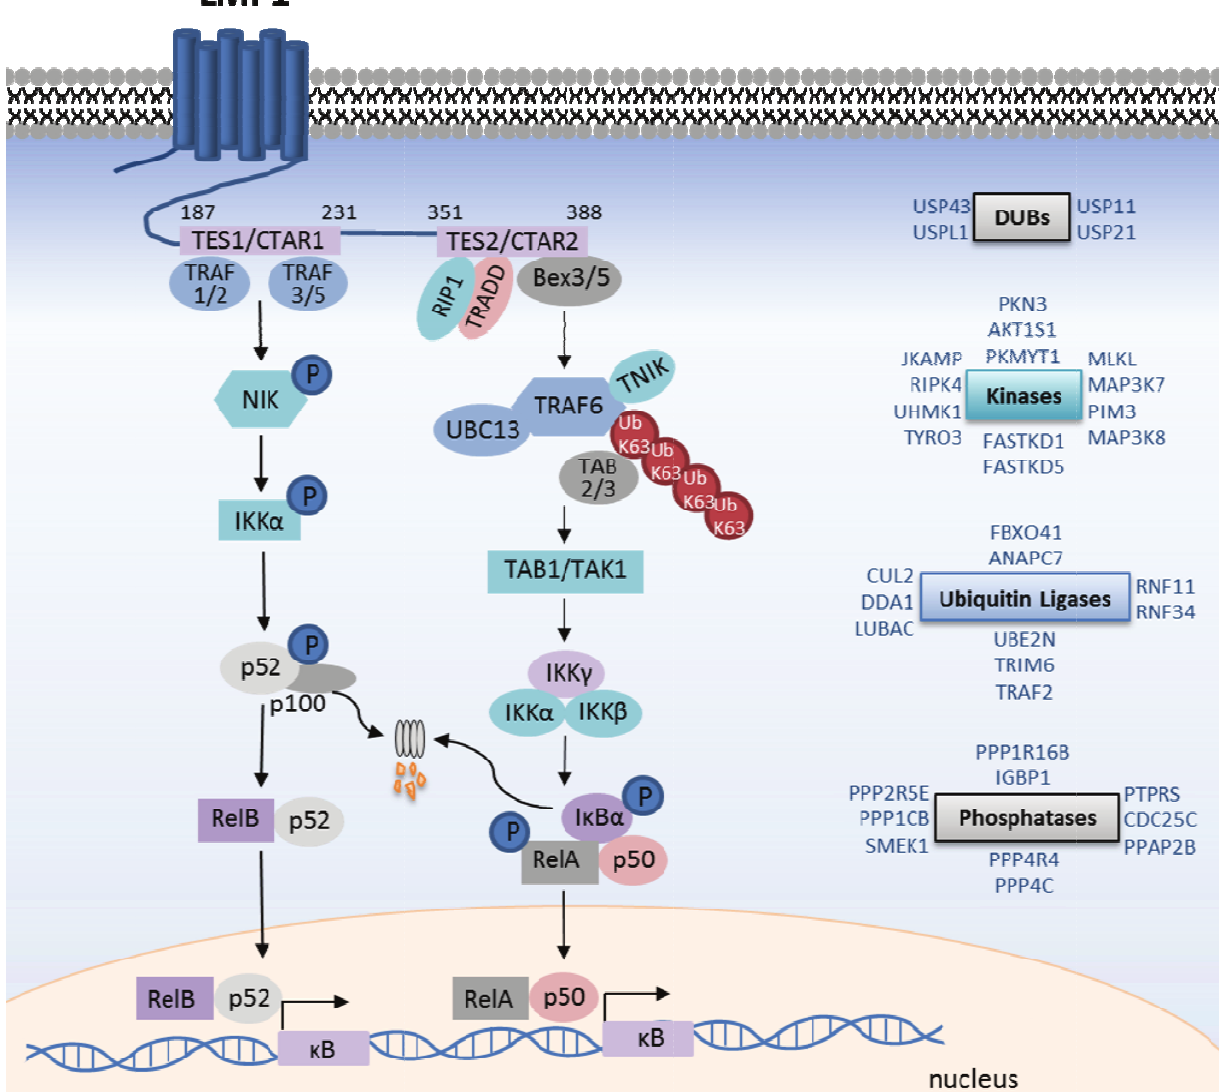
are sal -mediated c s in ubiqui